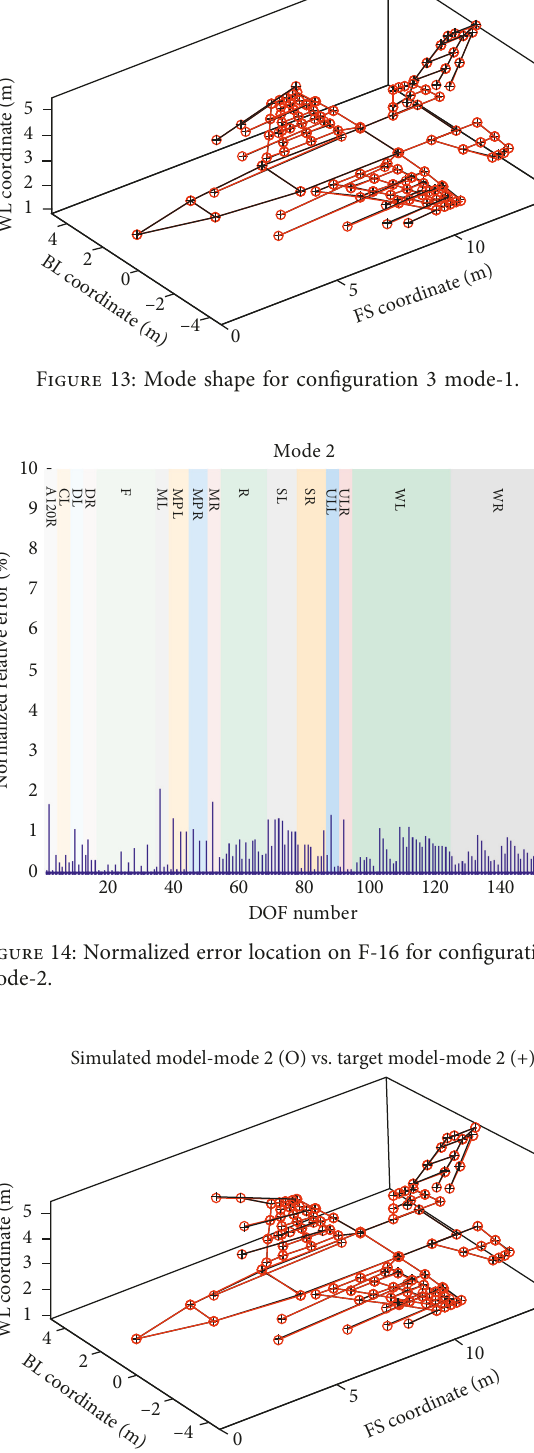
Figure 15: Mode shape for configuration 3